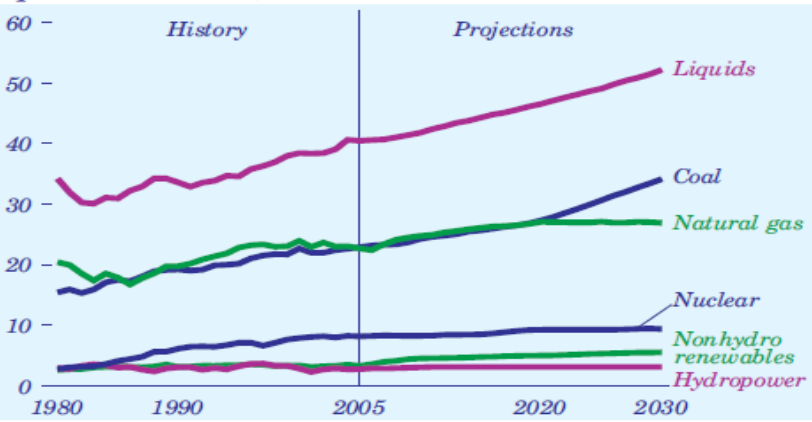
Figure1: Consumption growth of various energy in non-renewable and renewable in the world from 1980 to 2030 (EIA, 2007), X: year, Y: Quadrillion